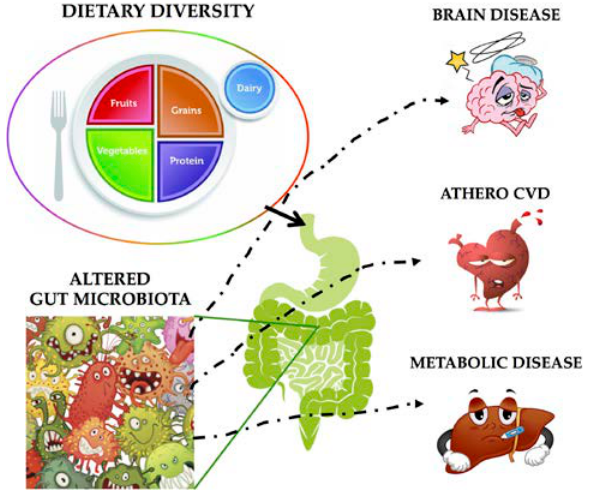
Figure 2. Impact of the dietary intake on gut microbiota and on human disease. Athero CVD (cardiovascular disease ) means Atherosclerotic cardiovascular disease.